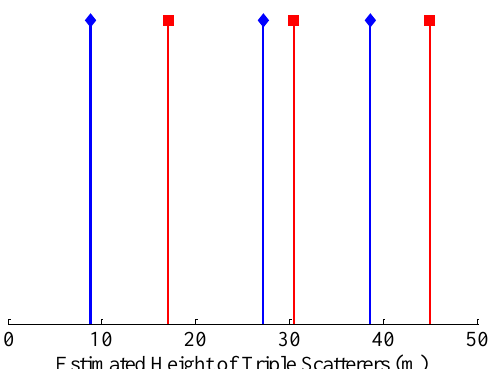
Figure 14. Study results: Height of triple scatterers, corresponding the red square and blue diamond in Figure